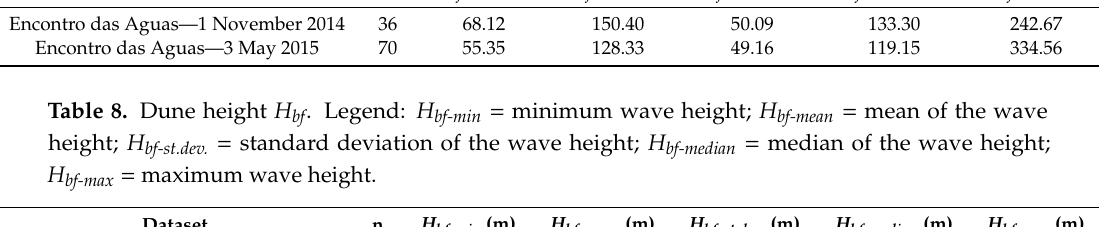
Table 7. Wavelength λ bf . Legend: λ bf - min = minimum wavelength; λ bf-mean = mean of the wavelength; λ bf-st.dev = standard deviation of the wavelength; λ bf-median = median of the wavelength; λ = maximum wave length. bf-max Table 8. Dune height H bf . Legend: H bf-min = minimum wave height; H bf-mean = mean of the wave height; H bf-st.dev. = standard deviation of the wave height; H bf-median = median of the wave height ; H bf-max = maximum wave height.